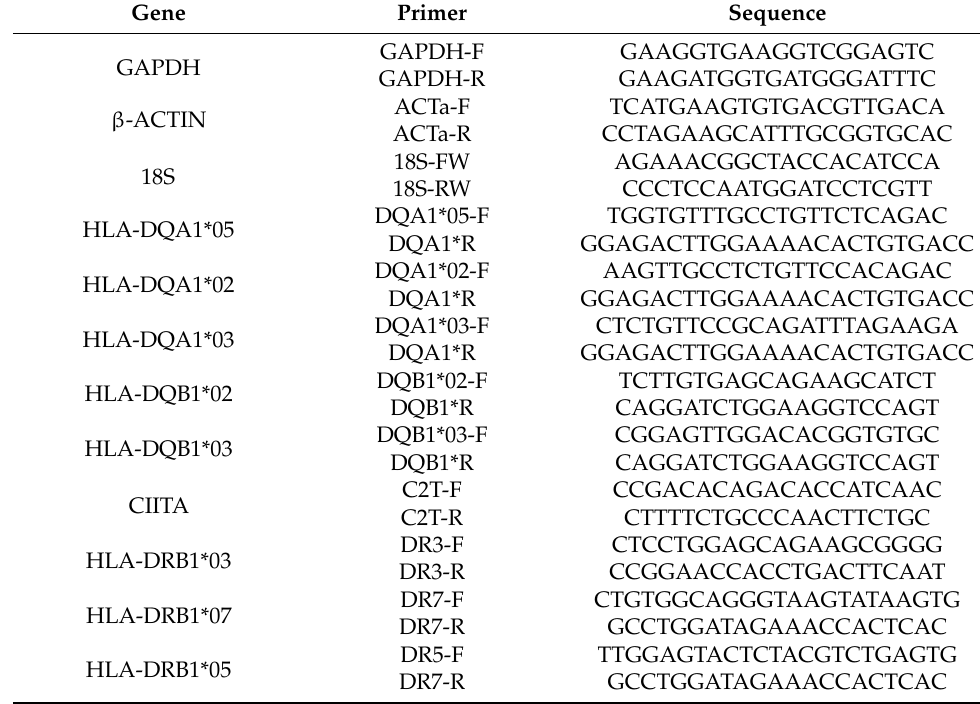
Table 3. Primers used for